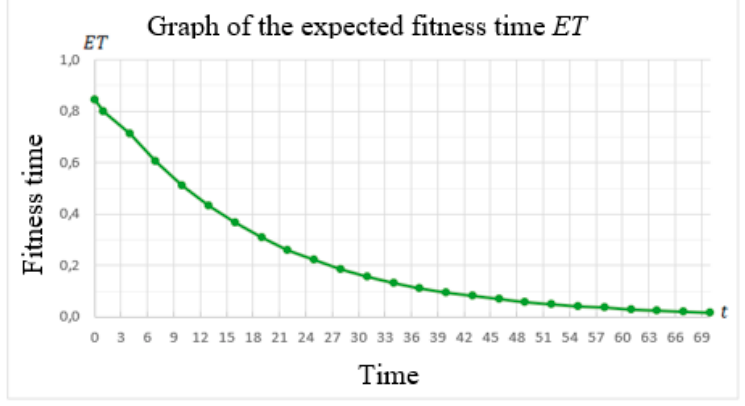
Figure 7. Expected fitness time.